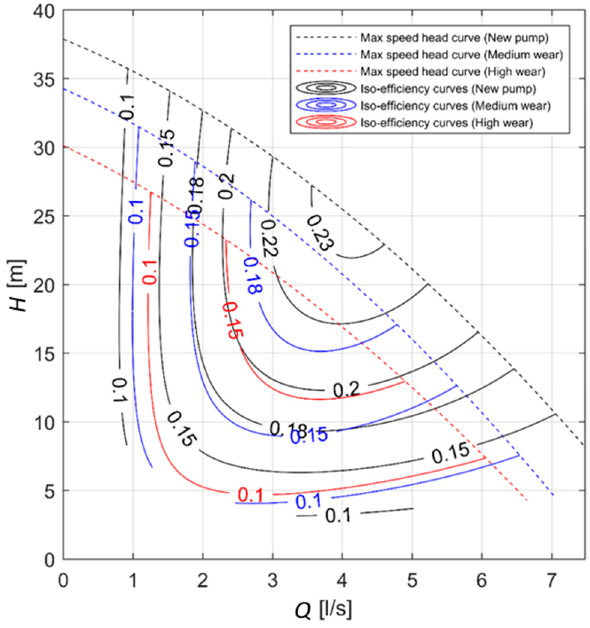
Figure 8. Comparison of characteristic and efficiency curves for different stages of wear.